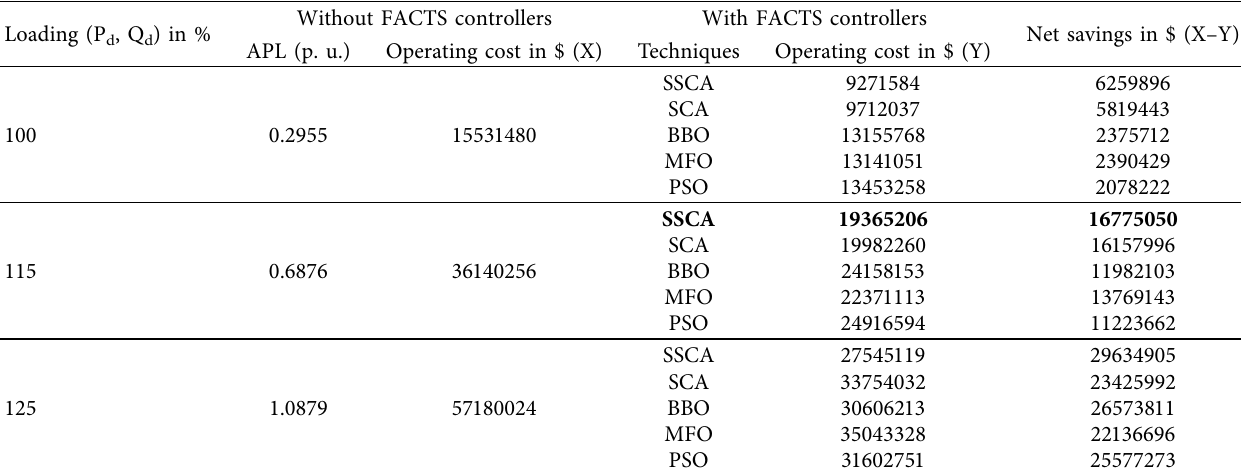
Table 7: Cost analysis without and with FACTS controllers for IEEE 57 bus system (best values are presented in bold). Loading (P d , Q d ) in